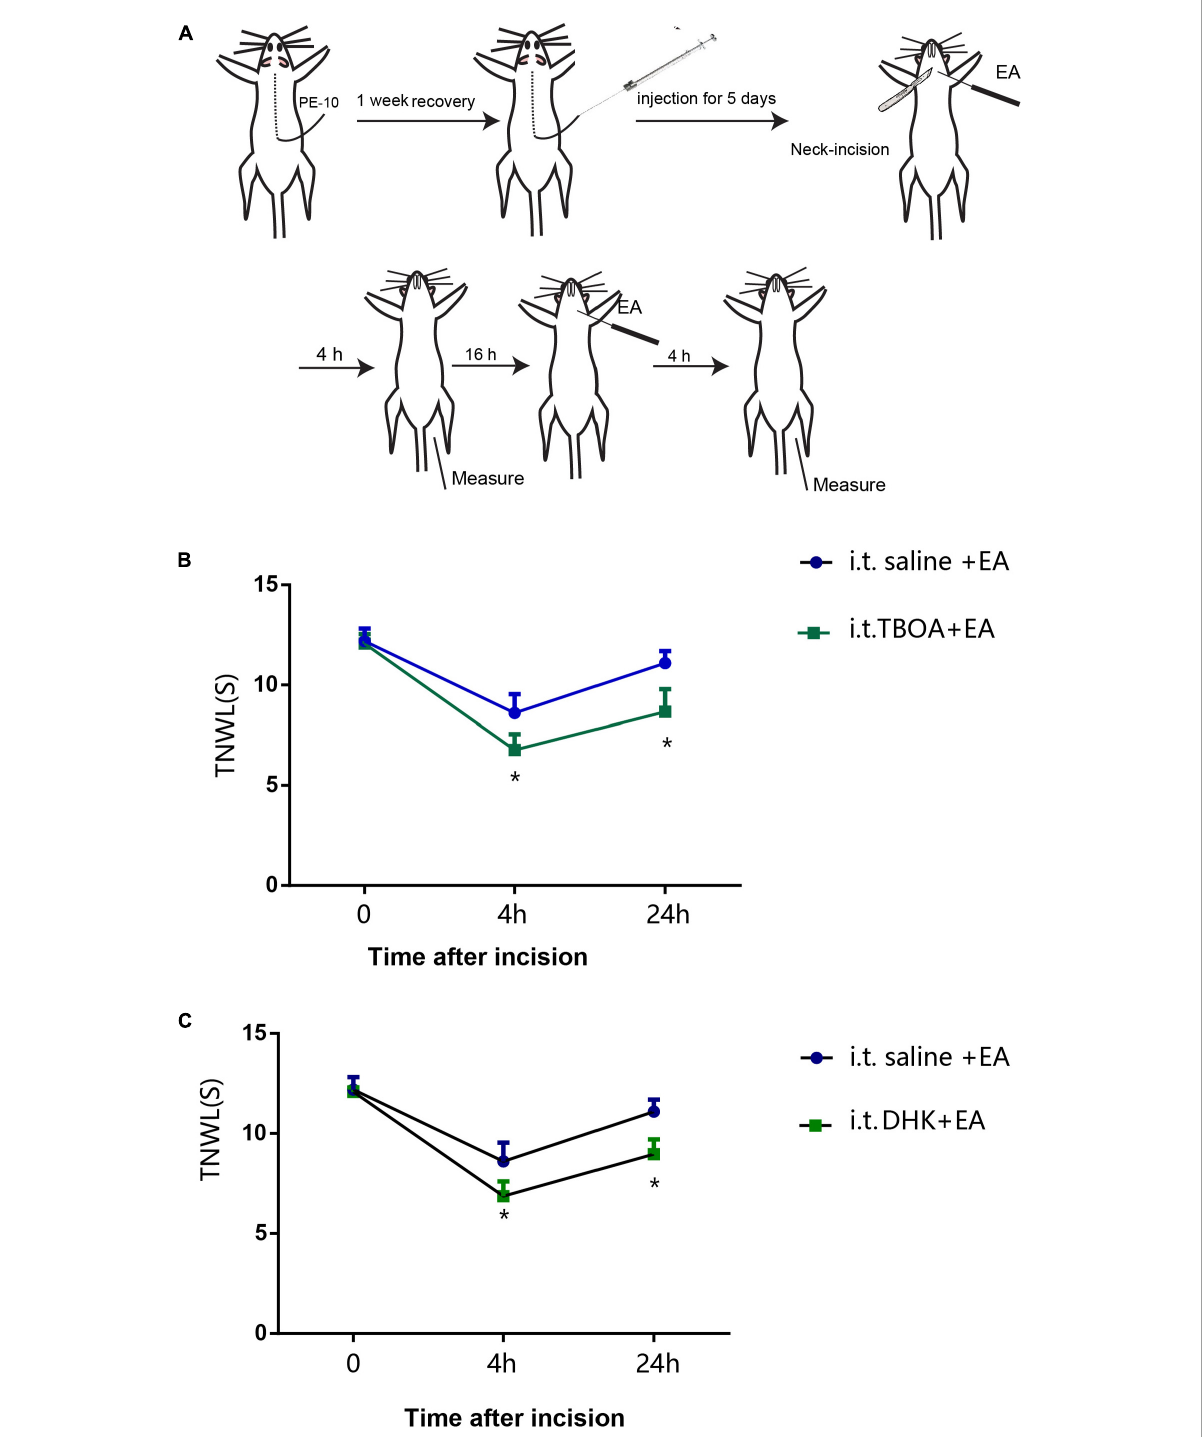
FIGURE9 Intrathecal injection of glu aspartate transporter (GLAST) antagonist (DL-threo-beta-Benzyloxyaspartate, DL-TBOA) and glu transporter-1 (GLT-1) antagonist (dihydrokainate, DHK) diminishes the analgesic effect of EA LI18. (A) Schematic diagram showing the experimental procedures of i.t., electroacupuncture (EA) intervention of LI18, and behavioral measurements. (B,C) Significant reductions in the thermal pain threshold (TPT, thermal neck withdrawal latency, TNWL) at different time point after i.t. of GLAST antagonist TBOA (B) , and GLT-1 antagonist DHK (C) , separately (mean ± SD, N = 10 per group). i.t.: intrathecal injection; * P < 0.05, vs. the i.t.-saline + EA